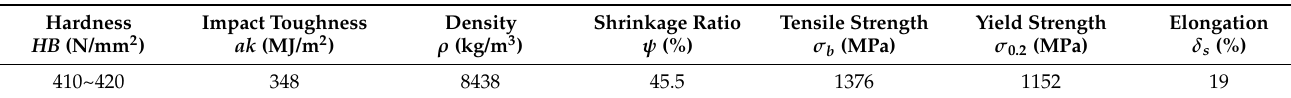
Table 3. Physical properties of the superalloy GH4169 (20 °C).